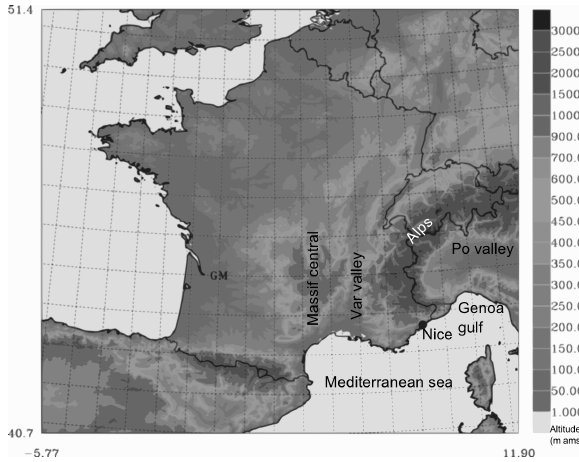
Fig. 11. Simulation grid domain and name of locations of